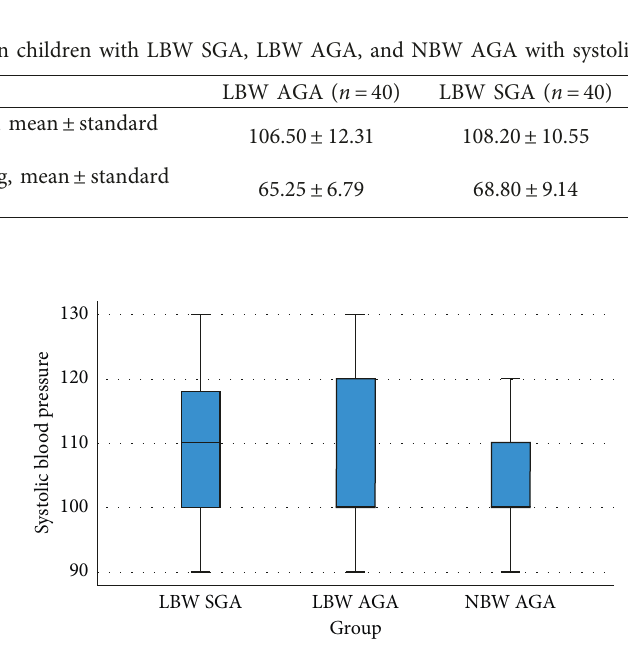
Figure 1: Box plot association between birth weight and systolic blood pressure of children with a history of LBW AGA, LBW SGA, and NBW AGA.